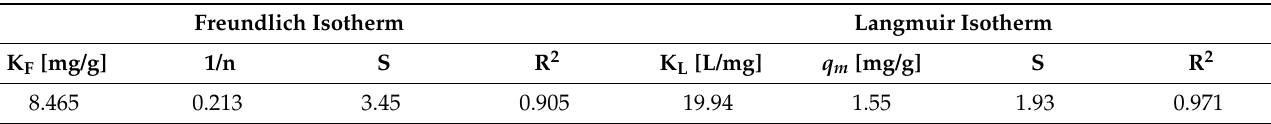
Table 1. Calculated values derived from Freundlich and Langmuir isotherm models. Freundlich Isotherm Langmuir Isotherm K F [mg/g]